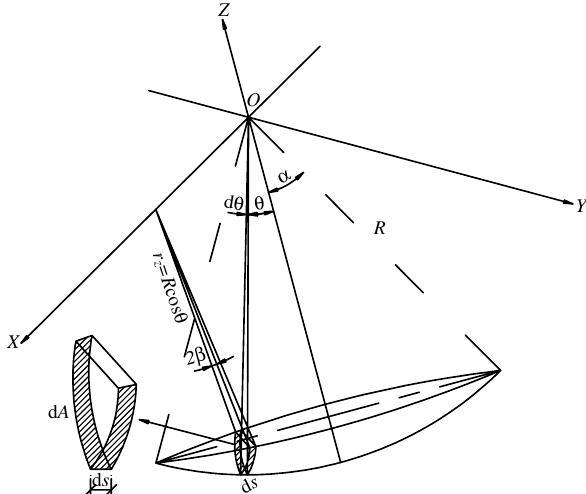
Figure 12. Modified calculating diagram of spherical hinge’s static friction